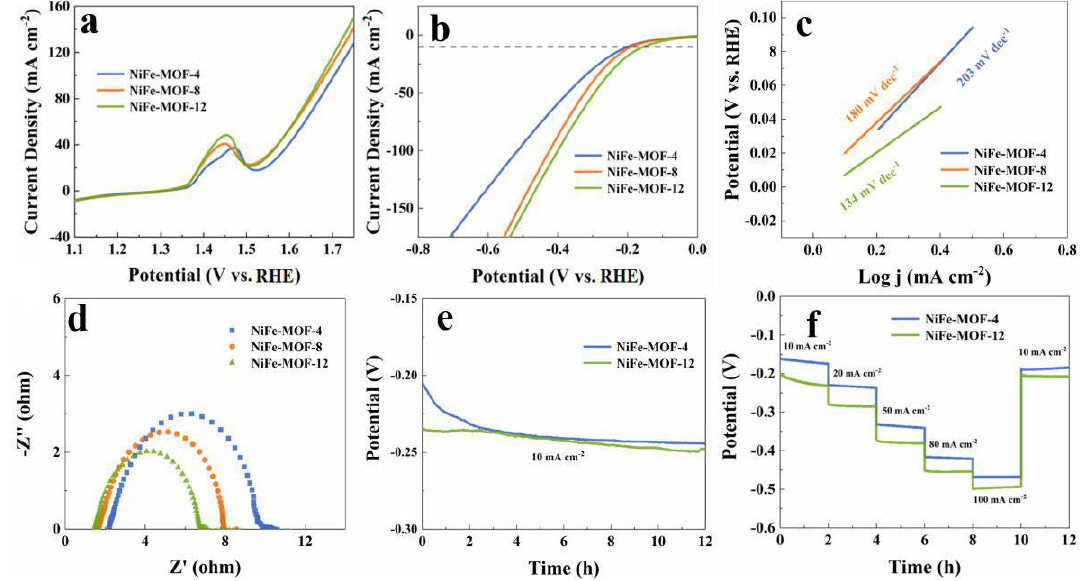
Figure 5. Comparison of electrocatalytic performance of NiFe-MOF-X (X = 4, 8, 12): ( a ) OER polari- zation curves, ( b ) HER polarization curves, ( c ) relevant Tafel slopes, ( d ) Nyquist diagram, ( e ) polarization curves; ( b ) HER polarization curves; ( c ) relevant Tafel slopes; ( d ) Nyquist diagram; chronopotentiometry curves at 10 mA cm −2 , and ( f ) galvanostatic test curves for HER under different ( e ) chronopotentiometry curves at 10 mA cm − 2 ; and ( f ) galvanostatic test curves for HER under current densities for NiFe-MOF-4 and NiFe-MOF-12. different current densities for NiFe-MOF-4 and NiFe-MOF-12.